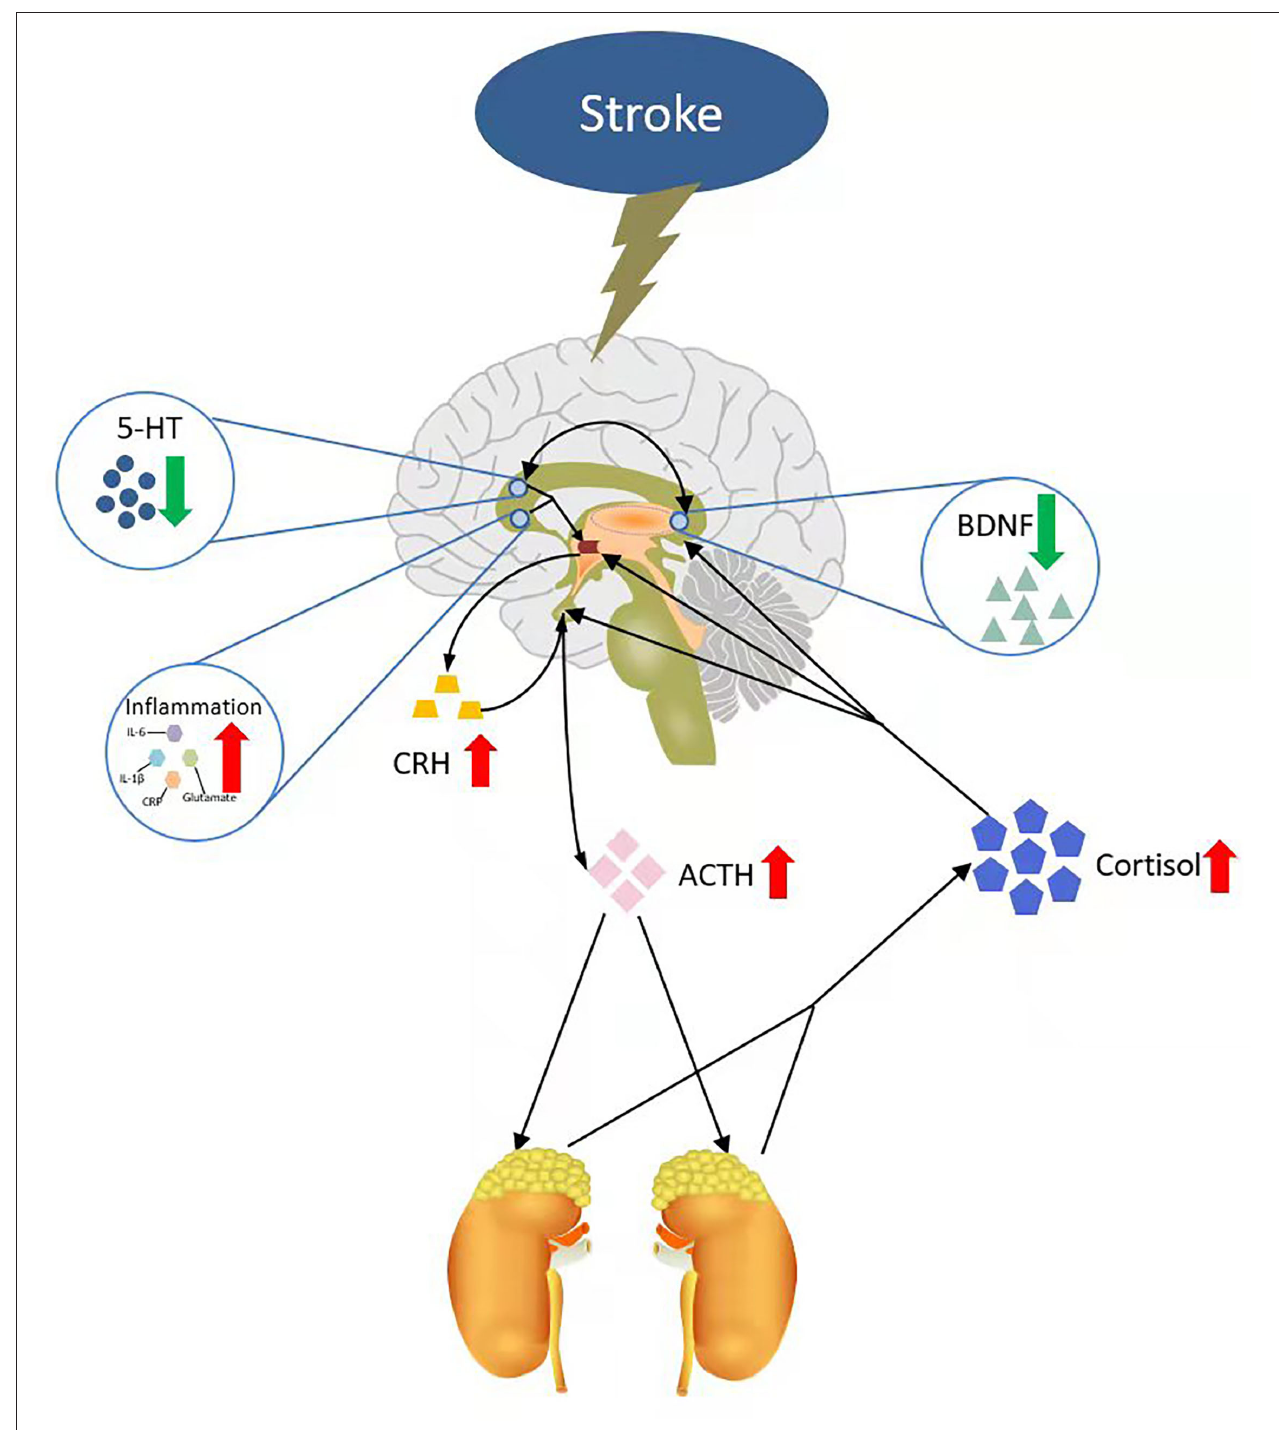
FIGURE 1 | A neural mechanism model of PSD. IL-6, interleukin-6; IL-1 β , interleukin-1 β ; CRP, C-reactive protein; CRH, corticotropin-releasing hormone; ACTH, adrenocorticotropic hormone; 5-HT, 5-hydroxytryptamine; BDNF, brain-derived neurotrophic factor.